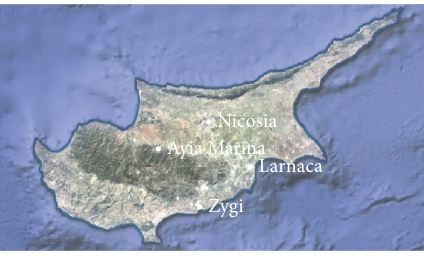
Figure 1: Locations of the four PM 10 measuring